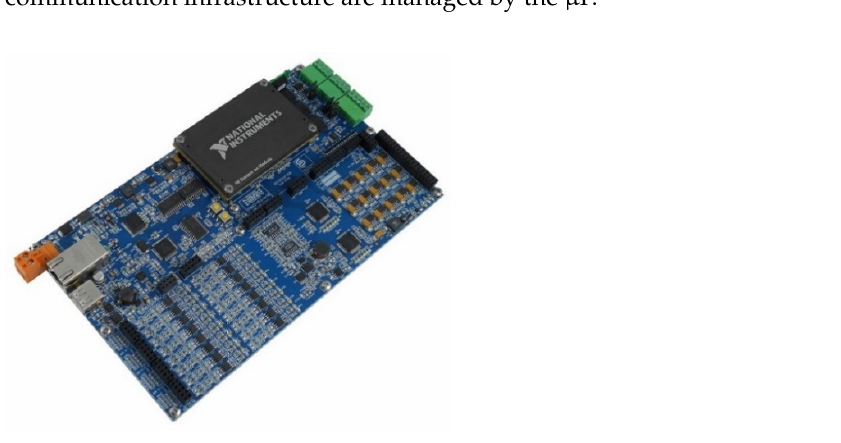
Figure 18. Control architecture with the National Instruments sbRIO-9651 System on Module (SoM).